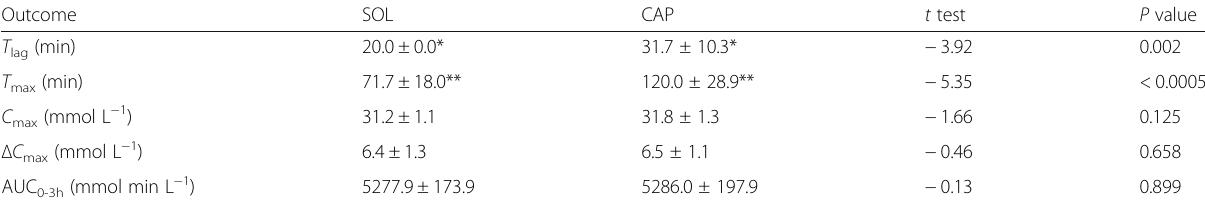
Table 2 Mean (± SD) pharmacokinetic response variables for bicarbonate in the SOL and CAP conditions, together with the statistical significance of the difference Outcome